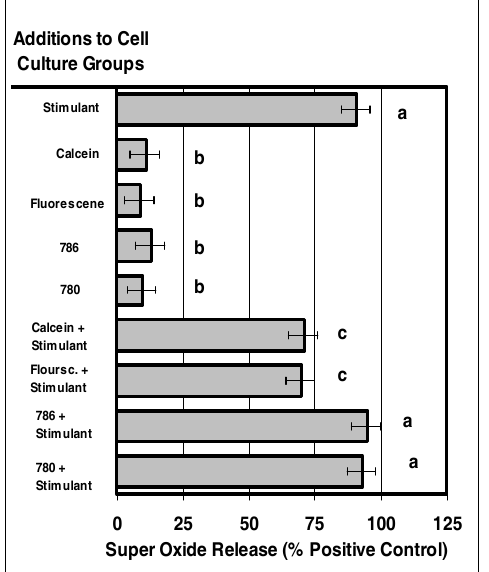
Figure 8: The internalization of VIS or NIR micro- sensor dyes did not alter neutrophil super oxide production in response to stimuli. Neutrophil cultures were treated with either vehicle, VIS micro-sensor dyes (fluorescein or calcein; 20 µg/10 6 cells), or NIR micro- sensor dyes (NIR-786 or NIR-780; 20 µg/10 6 cells) and incubated for 24 hours. After this incubation period, the cultures were stimulated with LPS for 24 hours. After the 24-hour stimulation period, the ability of neutrophils to produce super oxide was